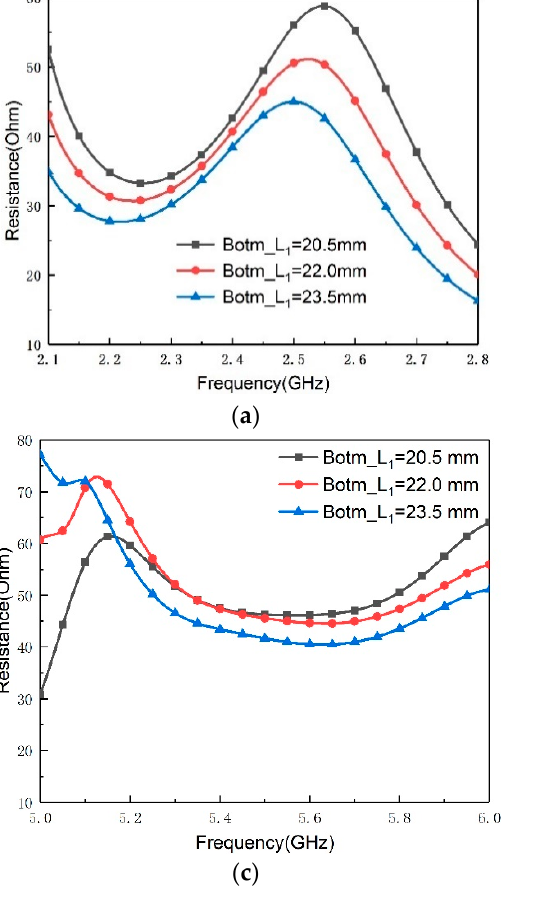
Figure 9. The input impedance of the antenna at various values of the Botm_L 1 parameter. ( a ) Resistance, ( b ) reactance at 2.45 GHz, and ( c ) resistance and ( d ) reactance at 5.8 GHz. Table 2. Design parameter values of proposed